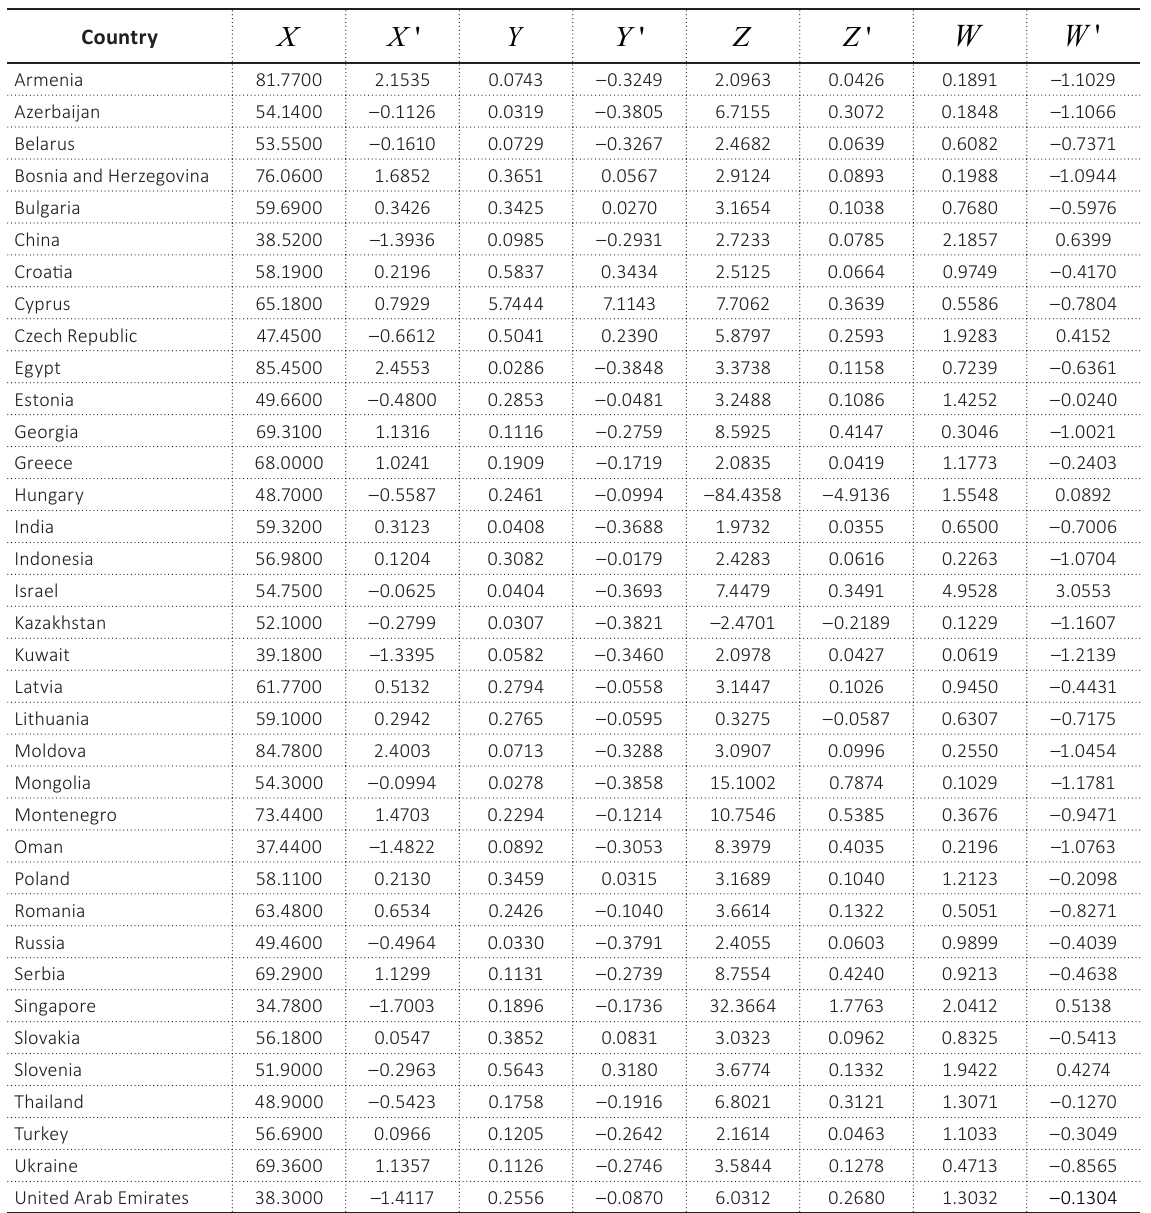
Table A1. Standardized values of the indicators for the BRI